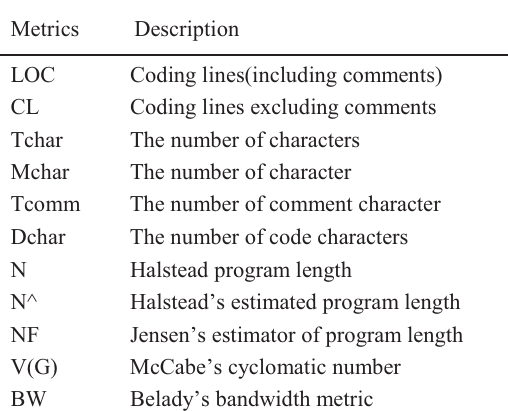
Table 1. MIS software metrics